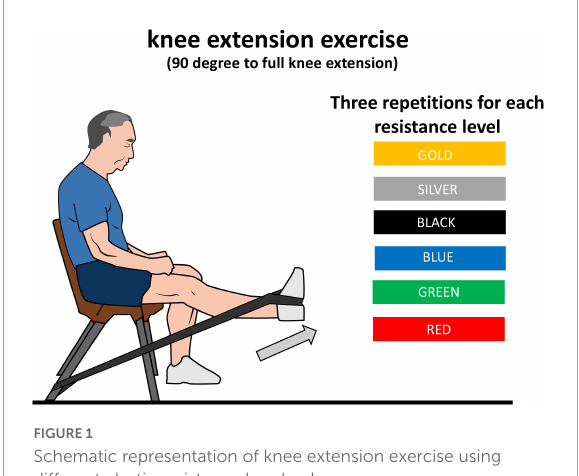
FIGURE1 Schematic representation of knee extension exercise using different elastic resistance band